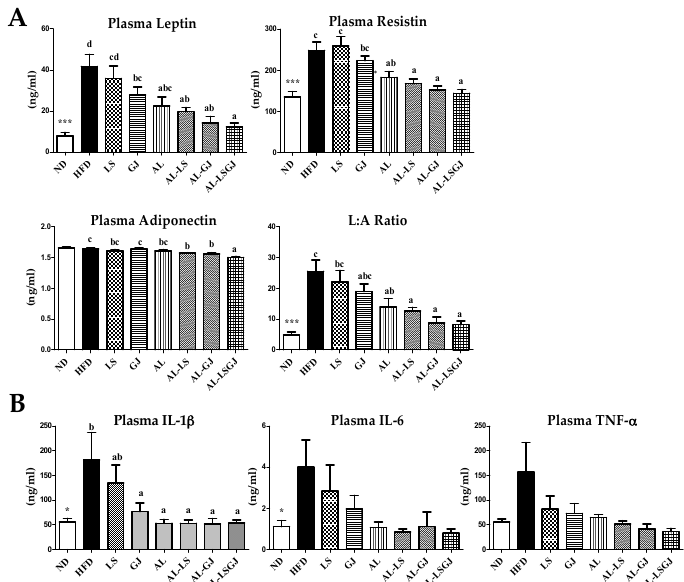
Figure 2. Effect of synbiotic supplementation for 12 weeks on plasma adipokine levels. ( A ) adipokine levels and ( B ) cytokine levels in diet-induced obese mice. Data are mean ± S.E.; Significant differences of ND versus HFD are indicated; * p < 0.05, *** p < 0.001; abcd Means with different superscript letters are significantly different among the groups ( p < 0.05); ND: normal diet (5% fat, w/w ); HFD: high fat diet (20% fat, 1% cholesterol, w/w ); LS: HFD + Lactobacillus sakei LS03 10 9 cfu/day; GJ: HFD + Leuconostoc kimchi GJ2 10 9 cfu/day; AL: HFD + 3% allulose; AL-LS: AL + Lactobacillus sakei LS03 10 9 cfu/day; AL-GJ: AL + Leuconostoc kimchi GJ2 10 9 cfu/day; AL-LSGJ: AL + Lactobacillus sakei LS03 + L. Leuconostoc kimchi GJ2 10 9 cfu/each/day; IL-6: interleukin-6; IL-1 β : interleukin-1 beta; TNF- α : tumor necrosis